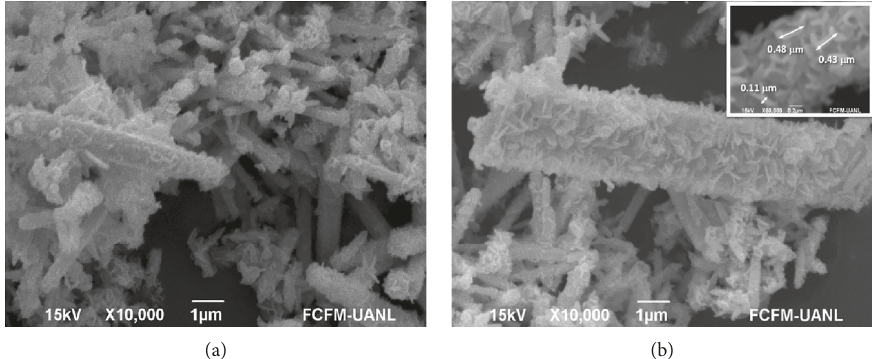
Figure 3: SEM micrograph obtained from different positions of a powder sample of decorated ZnO nanorods. The inset in Figure 2(b) shows the size measurements of some